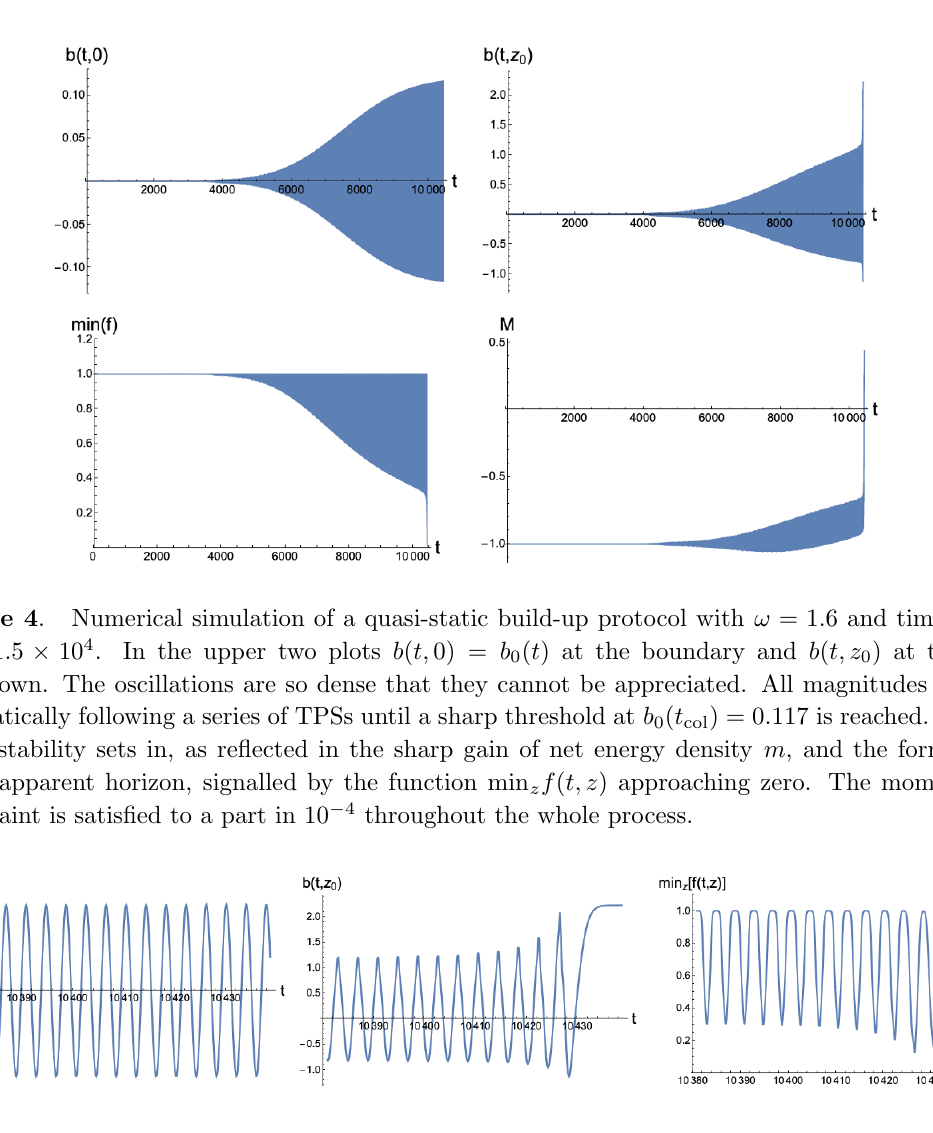
collapse. As compared with the TPS case in (cid:12)gure 5, we see the interior evolution becoming least, 7 corresponding to a sizeable window in driving